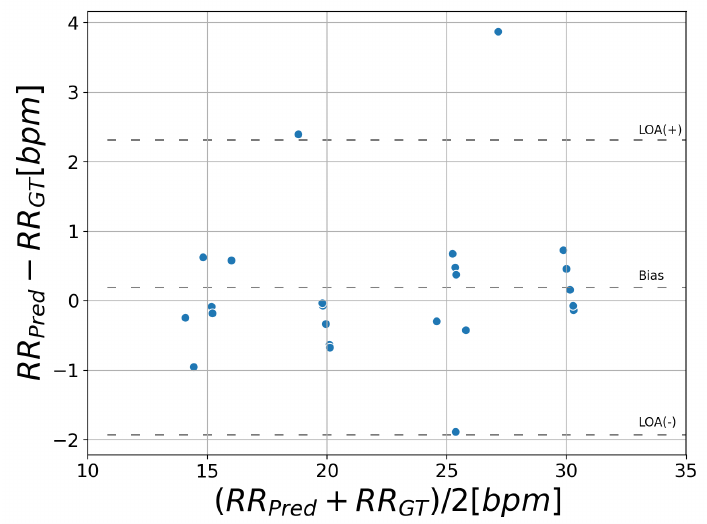
Figure 7. Bland–Altman plot of RR estimation: This plot shows the difference of RR against the mean on the x -axis. RR Pred and RR GT stand for the RR predicted by the proposed system and ground truth, respectively. The bias average is 0.19 bpm and the 95% limits of agreement vary between − 1.9 and 2.3